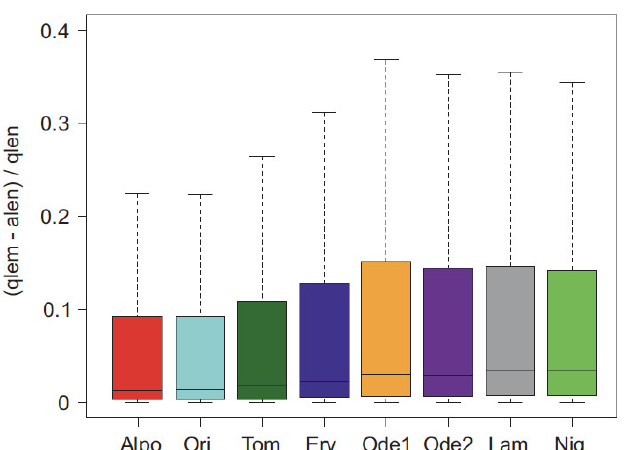
Figure 5. Boxplots displaying the variation in the relative distribution of the query alignment length over the CDC Redberry reference. Boxplots were drawn without outliers. Alpo ( culinaris ), Ori ( orientalis ), Tom ( tomentosus ), Erv ( ervoides ), Lam ( lamottei ), Nig ( nigricans ), Ode1 and Ode2 ( odemensis ).